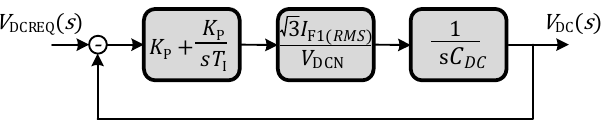
Figure 10. Dynamic model of HAPF dc link voltage regulation.